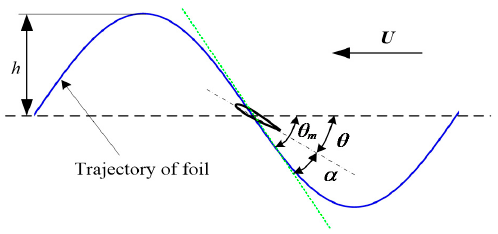
Figure 4. Definitions of relevant motion parameters.